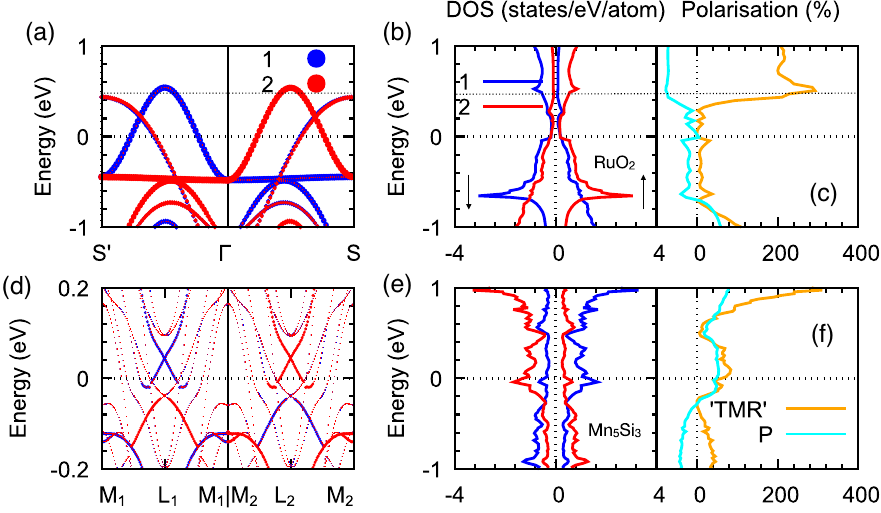
FIG. 4. First-principles calculations of TMR in RuO 2 [32] and Mn 5 Si 3 [31]. (a) – (c) are for RuO 2 and (d) – (f) for Mn 5 Si 3 . (a) Wave- vector- and sublattice- (blue and red, respectively) resolved energy bands. (b) Sublattice- (blue and red) and spin- (left and right) resolved density of states as a function of energy. (c) Energy-dependent TMR and spin polarization parameter (see the text). (d) – (f) The same as (a) – (c) for Mn 5 Si 3